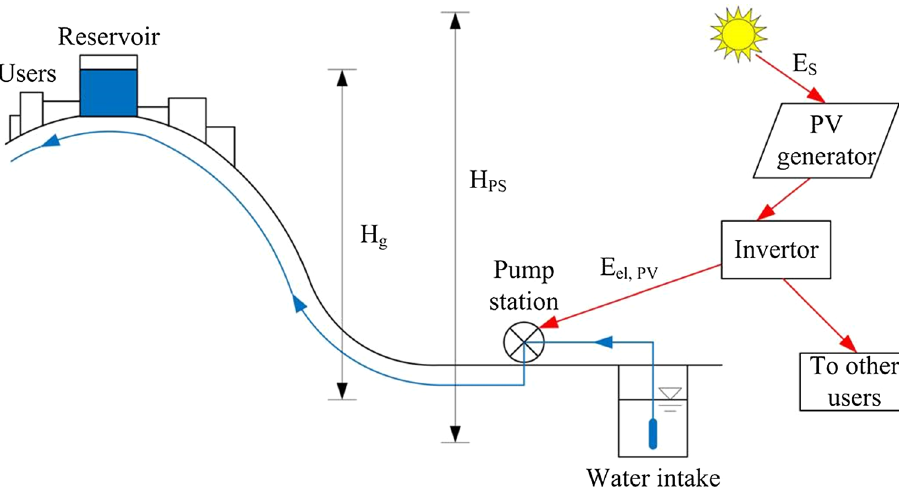
Fig. 1 Urban water supply system (UWSS) driven by solar photovoltaic (PV)